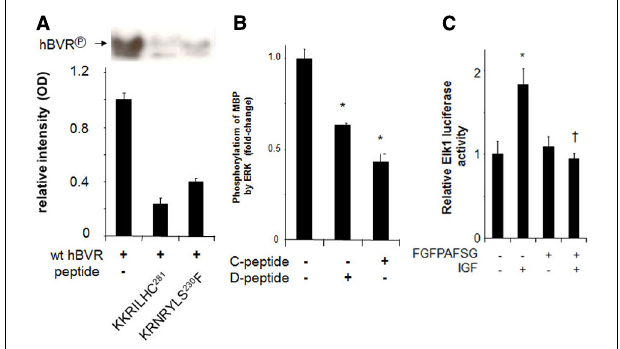
FIGURE 6 | Peptide inhibition of BVR and ERK1/2. (A) Autophosphorylation of BVR was determined in reaction mixtures that included no added peptide or either of the BVR-based peptides KKRILHC or KRNRYLSF. The products were detected by autoradiography (top) and quantified by densitometry (bottom). The peptide KRNRYLSF includes a potential IRK target site. (B) ERK2 kinase reactions with myelin basic protein as substrate were performed in the presence or absence of the BVR C-Box (FGFPAFSG) and D-Box (KKRILHCLGL) peptides, which inhibit interaction of BVR with ERK, * p < 0.01. (C) Peptide FGFPAFSG inhibits ERK-dependent signaling. Cells were transfected with Elk1 expression plasmid and